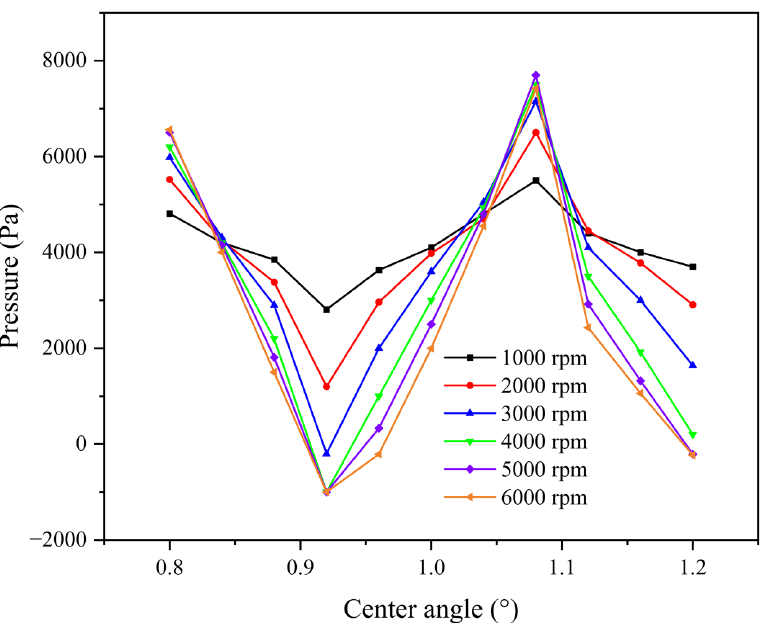
Figure 16. Pressure distribution in a single textured dimple with the cavitation effect at different rotational speeds.